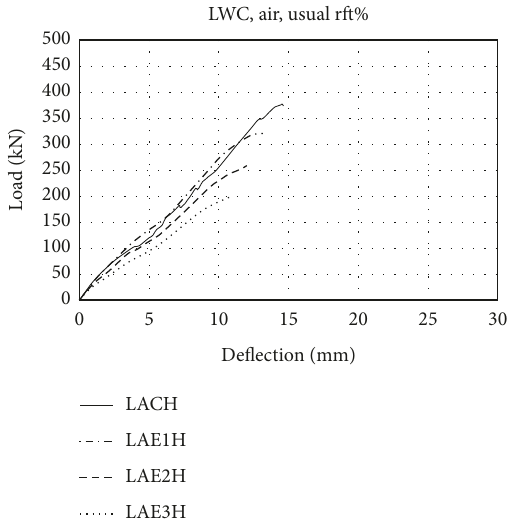
Figure 6: Effect of e / t ratio on the load-deflection curves for LWC with usual RFT%.